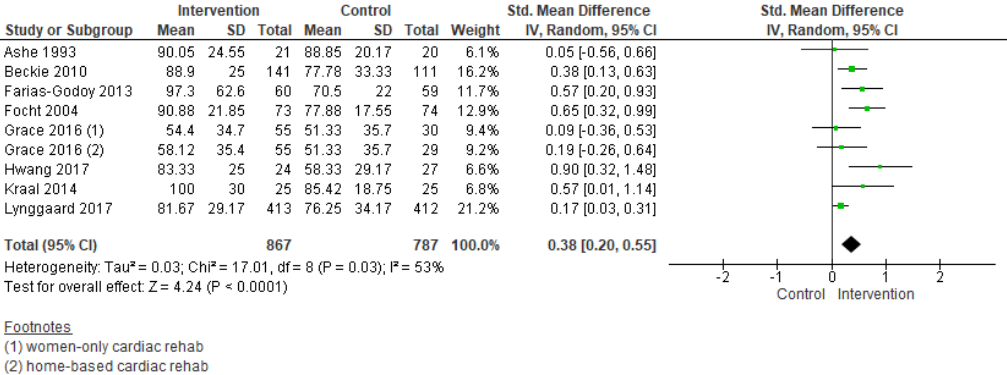
Figure 6. Forest plot summarizing the effect of cardiac rehabilitation utilization interventions on adherence. Note: Boxes represent the standardized mean difference (SMD) for individual trials. The boxes are proportional to the weight of each study in the analysis and the lines represent their 95% confidence interval (CI). The diamond represents the pooled SMD, and its width represents its 95% CI.